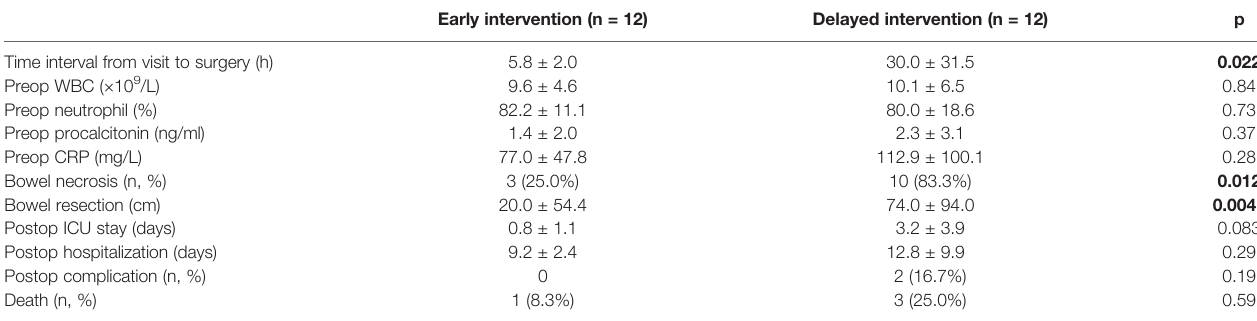
TABLE 4 | Comparison between early and delayed surgical intervention of Petersen ’ s hernia.